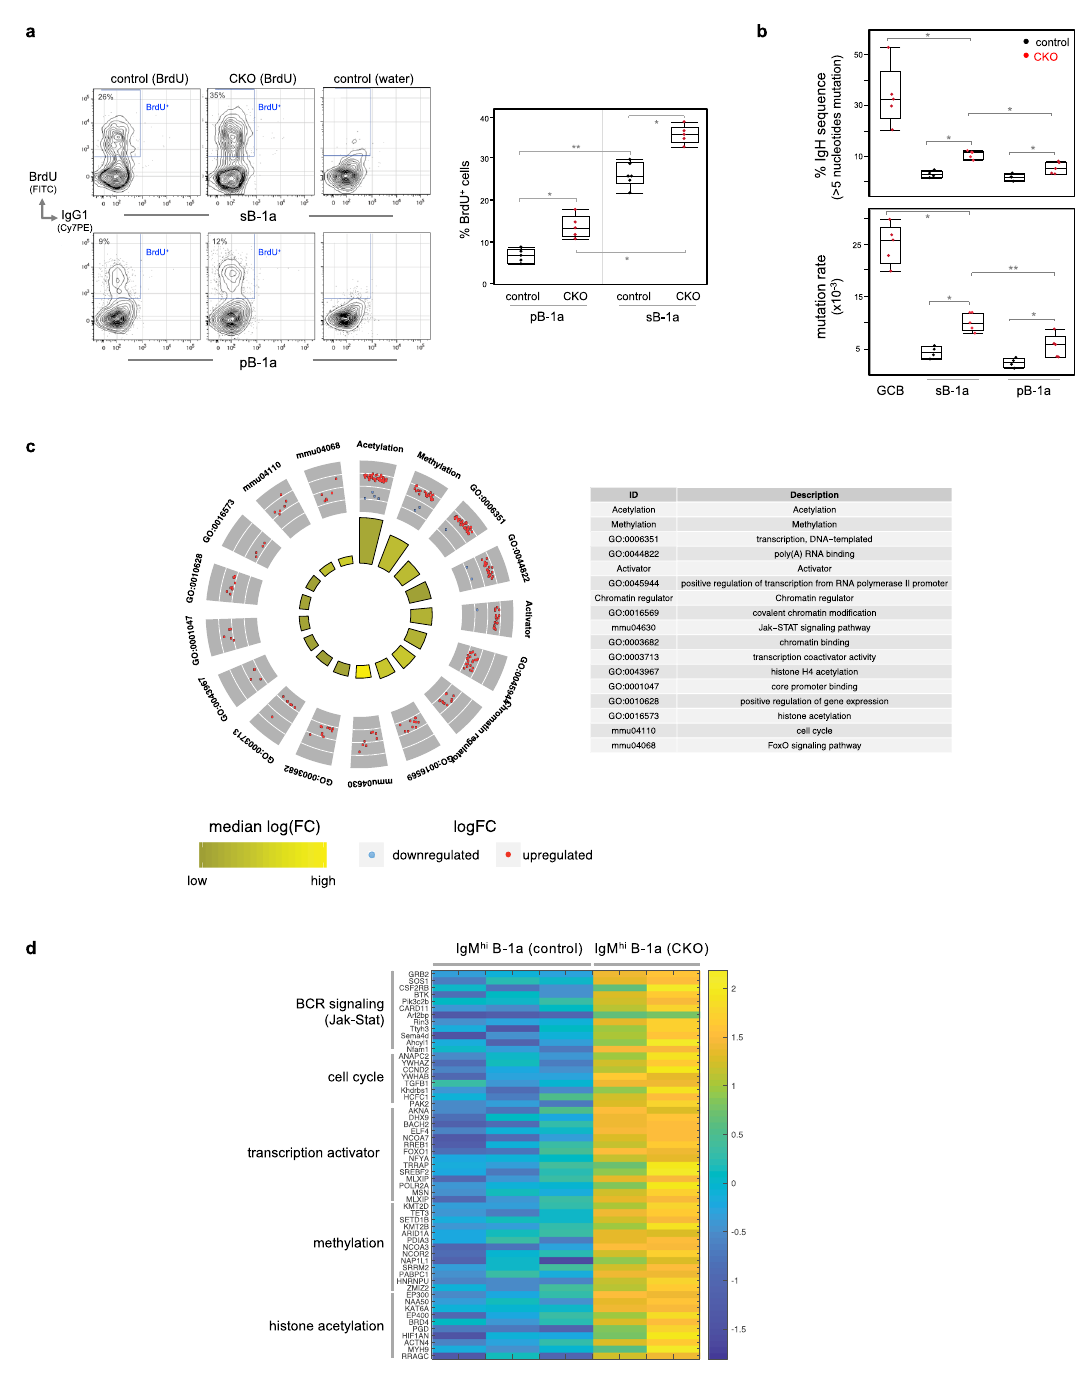
Fig. 2 B-1a cells in CKO mice show increased self-replenishment and upregulate activation gene programs. a Control or CKO mice were fed with BrdU- containing water for 6 days and BrdU incorporation (BrdU + ) by splenic and peritoneal B-1a cells in these mice was measured by FACS analysis. B-1a cells were gated as CD19 + IgM hi IgD lo/neg CD21 lo/neg CD43 + CD5 + . Data summarizing the percentages of BrdU + cells in sB-1a or pB-1a cells for fi ve independent experiments is shown. Each dot represents data for an individual mouse. * p < 0.01, ** p < 0.006, nonparametric Wilcoxon one-way test. b sB- 1a, pB-1a, and GC B (CD19 + CD95 + CD38 neg ) cells in control or CKO mice were sorted and then sequenced to obtain their IgH transcripts. The percentages of IgH transcripts containing >5 nucleotide changes and the mutation rate for each population are shown, n = 4 – 5 biologically independent samples per subset, each sample was from an individual mouse, * p < 0.01, ** p < 0.02, nonparametric Wilcoxon one-way test. c Circular visualization graph shows the selected GO terms for differentially expressed genes between splenic B-1a cells in control and CKO mice. Each dot in the outer circle represents an individual upregulated (red) or downregulated (blue) gene. Genes of the same functional term are grouped together and the detail of each group is shown in the right table. The colored bars in the inner circle summarize the median folds change of the genes sharing the same functional term. d Heat- map shows the expression levels of listed genes measured by RNA-seq. Each row represents data of an individual gene. Genes with the same functional terms are grouped together. Each column represents data for an individual splenic IgM hi B-1a cell sample from control or CKO mice. All mice are 2 – 3 months old. Box plots in a , b : box draws 75% (upper), 50% (center line) and 25% (down) quartile, the maxima and minima outliers are shown as top and bottom line, respectively.